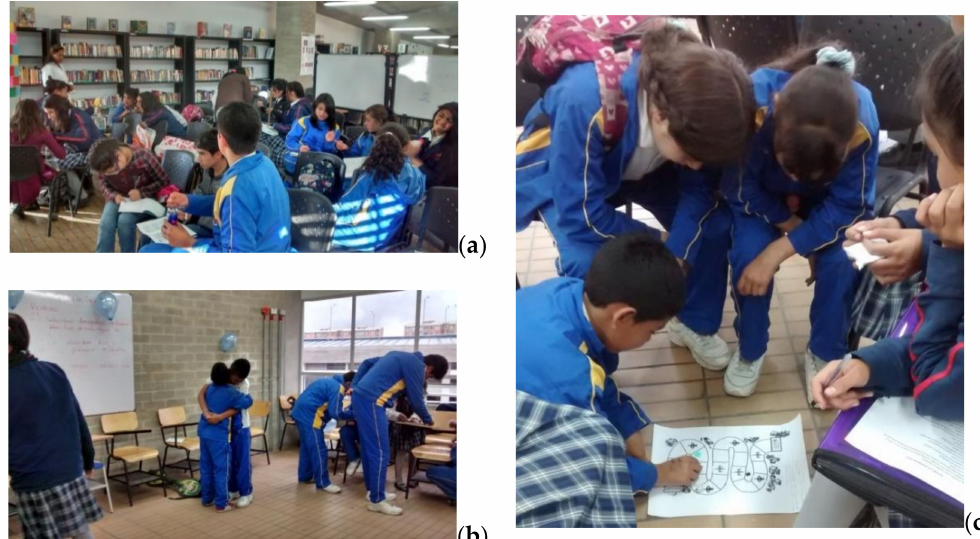
Figure 2. Examples of learning activities focused on residential water saving: ( a ) Workshop on “sources of water”, ( b ) ludic activity on water issues, ( c ) game on water saving techniques.